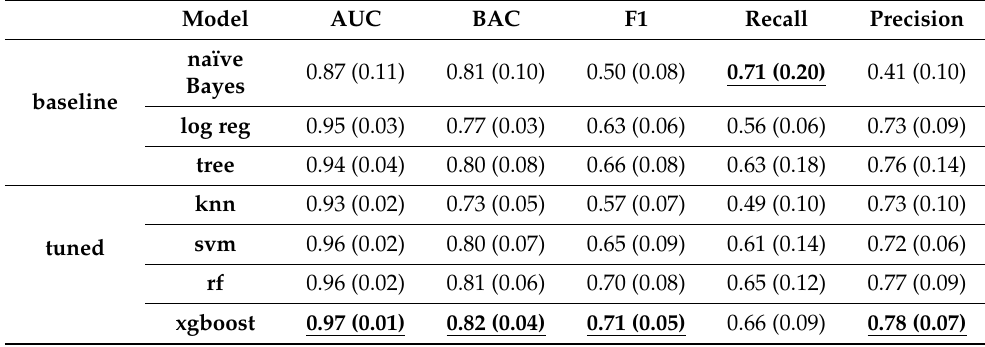
Table 4. Comparison of tuned ML models and baseline models where convective was chosen to be the positive class (1) and stratiform was chosen to be the negative class (0). The arithmetic mean (standard deviation) of the AUC, BAC, F1 score, recall and precision are compared. Best scores are the closest to 1 and are underlined and in bold. Model AUC BAC F1 Recall Precision